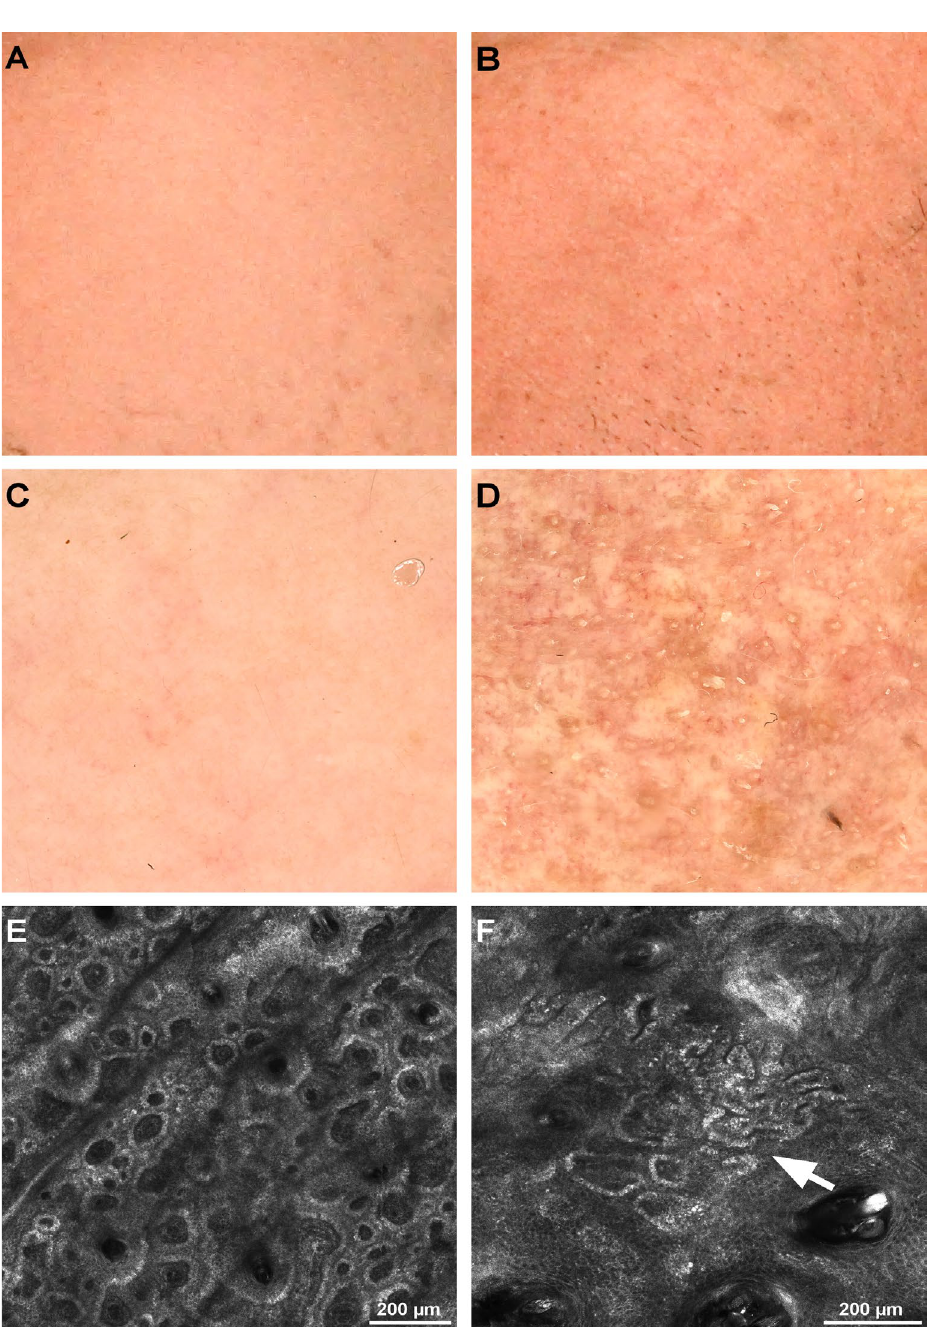
Figure 6. Clinical, dermoscopy, and confocal microscopy (RCM) images of regular and polycyclic papillae. ( A ). Clinical image of left cheek skin of a 36-year-old male. ( B ). Clinical image of left cheek skin of an 80-year-old male. ( C ). Dermoscopy image of the patient in panel A. ( D ). Dermoscopy image of the patient in panel B. ( E ). RCM mosaic showing regular papillae in the 36-year-old male. ( F ). RCM mosaic showing polycyclic papillae (white arrow) in the 80-year-old